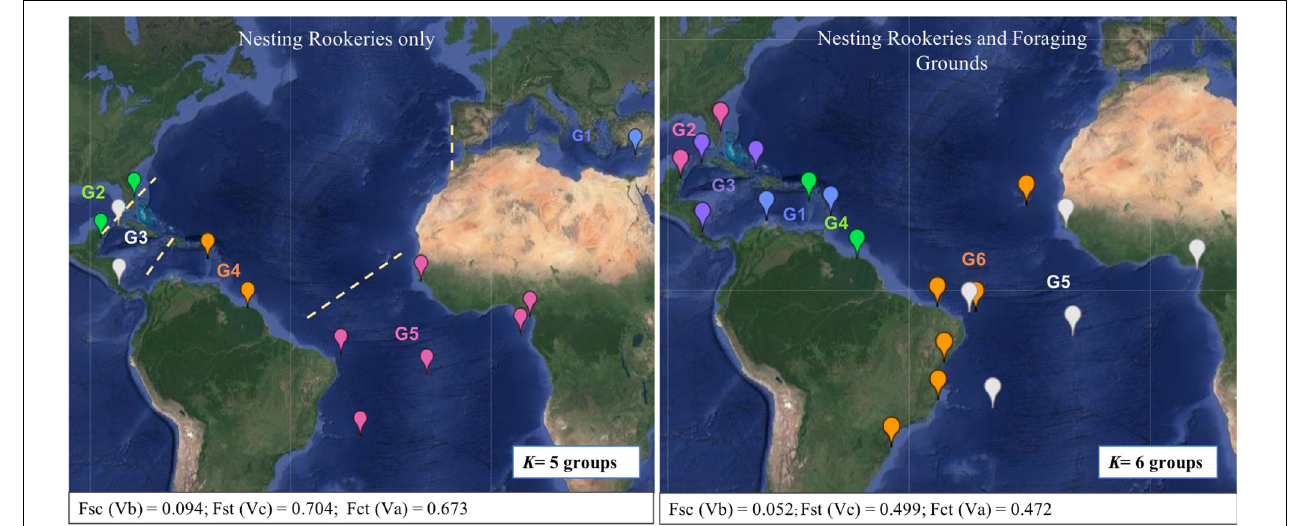
FIGURE 3 | Geographic location of Chelonia mydas population groups ( K ) inferred by SAMOVA analyses (represented by different colors). In the left K = 5 considering nesting rookeries (NRs) only; and in the right K = 6 considering NRs and foraging grounds. Dashed lines indicate possible geographic barriers to dispersal between